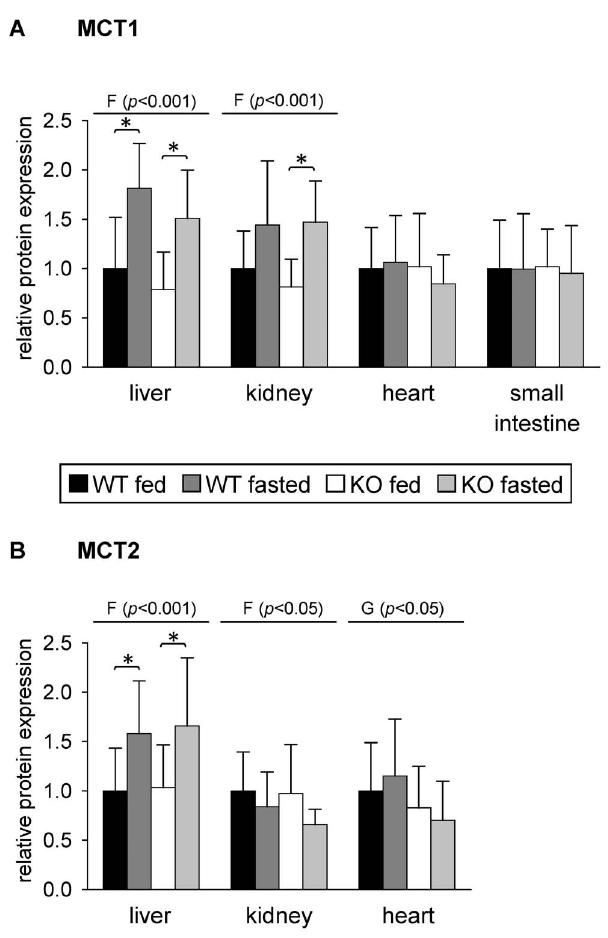
Figure 4. Relative protein expression of (A) monocarboxylate transporter (MCT)-1 and (B) MCT2 in mouse tissues in response to fasting and PPAR a . Values represent means 6 SD of relative protein expression of wildtype (WT) and PPAR a knockout (KO) mice that were fed ad libitum or fasted for 48 h (n=16). Data were analyzed by two-way ANOVA. Classification factors were genotype, fasting, and the interaction between both factors. P -values revealed by two-way ANOVA are noted above the figures. Individual means of the treatment groups were compared by Tukey’s test in case of variance homogeneity. In case of variance heterogeneity, as revealed by Levene’s test, individual means were compared by Games Howell test. Horizontal brackets represent differences between groups in post-hoc comparison (* p , 0.05).